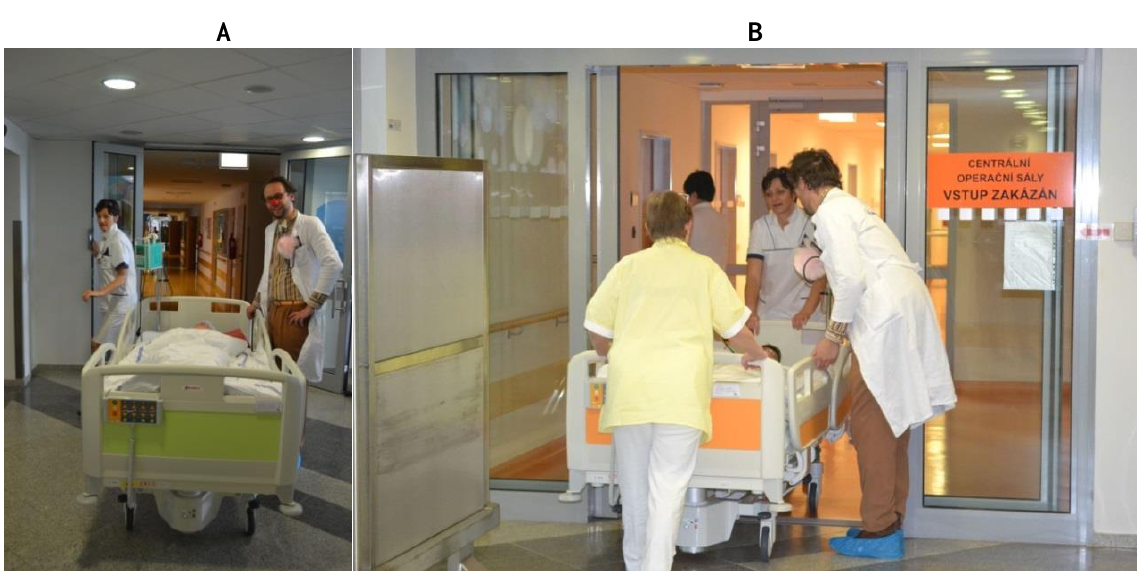
Figure 4. Lukáš Houdek, a.k.a. RED NOSES, clown Dr. Ivan Motyka (Zdravotní Klaun, CZ) helps patients preparing for